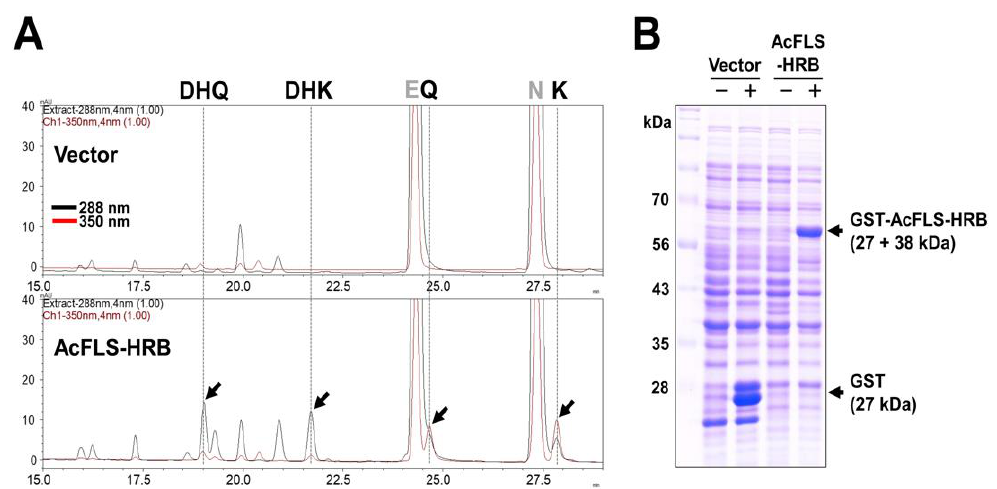
Figure 2. In vivo substrate-feeding assay of AcLFS-HRB enzyme activity. A . E. coli strain BL21 cells harboring recombinant GST (Vector) and expressing GST-AcFLS-HRB were simultaneously fed with flavanones (naringenin [N] and eriodictyol [E]), and the resulting dihydroflavonols (DHK